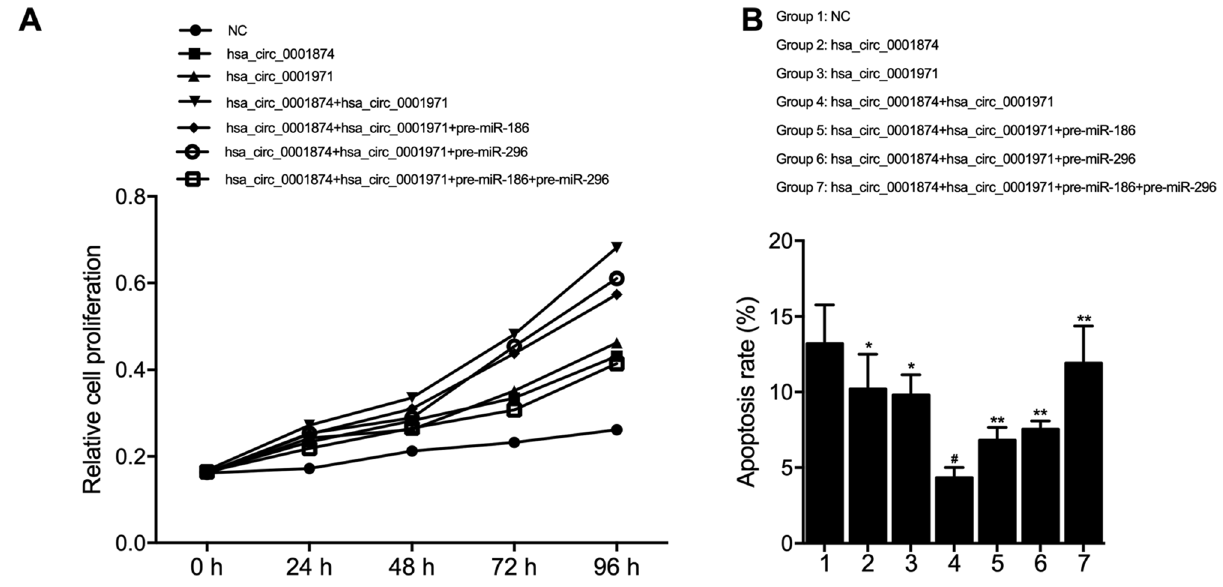
Figure 7. The overexpression of circ_0001971 and circ_0001874 synergistically promoted cell proliferation and suppressed cell apoptosis, while the overexpression of miR-186 and miR-296 obstructed the above effects. ( A ) Proliferation indicated by OD value at 570 nm was most increased in the hsa_circ_0001874 + hsa_circ_0001971 group. Although the proliferation was comparable between the hsa_circ_0001874 group and hsa_circ_0001971 group, the proliferation was the lowest in the NC group. Moreover, the up-regulation of miR-186 and/or miR- 296 suppressed cell proliferation promoted by circRNA overexpression; ( B ) Apoptosis rate was most reduced in the hsa_circ_0001874 + hsa_circ_0001971 group. Although the apoptosis rate was comparable between the hsa_circ_0001874 group and hsa_circ_0001971 group, the apoptosis rate was the highest in the NC group. Meanwhile, the up-regulation of miR-186 and/or miR-296 increased apoptosis rate suppressed by circRNA overexpression (*P value < 0.05 vs. NC group; # P value < 0.05 vs. hsa_circ_0001874 group; **P value < 0.05 vs. hsa_circ_0001874 + hsa_circ_0001971